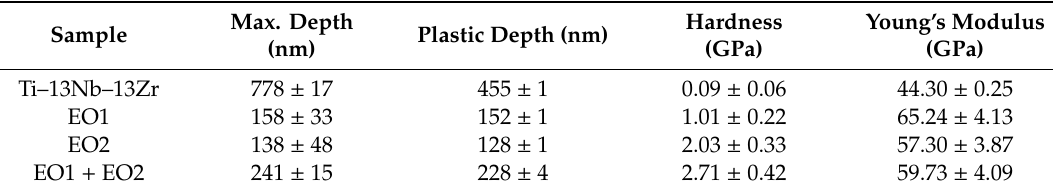
Figure 6. XRD spectra. ( a ) Alloy Ti–13Nb–13Zr; ( b ) alloy after EO1 treatment; ( c ) alloy after EO2 treatment; ( d ) alloy after EO1 + EO2. Table 4. Mechanical properties of the tested